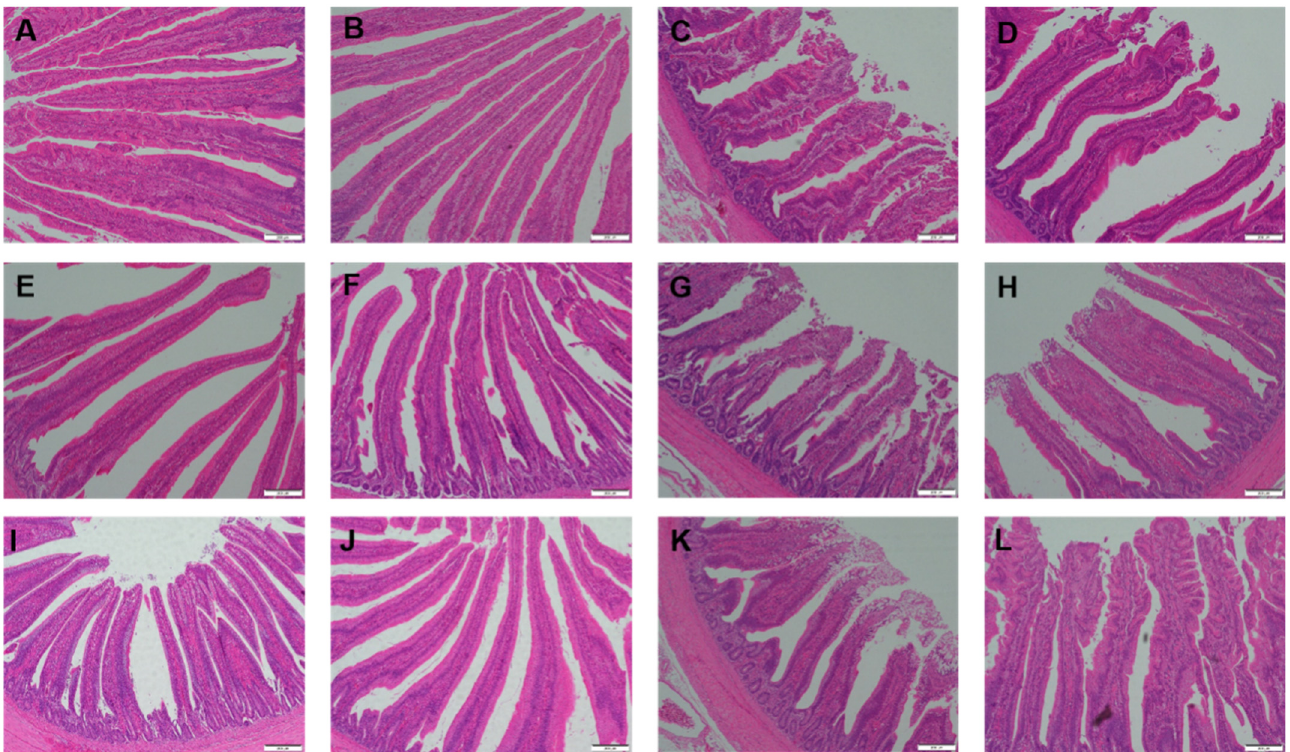
Figure 1. Intestinal mucosal histological appearance (hematoxylin and eosin) of the effect of Cardamine violifolia on the intestinal morphology of broilers challenged and unchallenged intraperitoneally with LPS. Original magnification 100×. Scale bars = 200 μ m. ( A – D ) Duodenum histological appearance of the broilers treated by SeNa-SS, SeCv-SS, SeNa-LPS, and SeCv-LPS, respectively. ( E – H ) Jejunum histological appearance of the broilers treated by SeNa-SS, SeCv-SS, SeNa-LPS, and SeCv-LPS, respectively. ( I – L ) Ileum histological appearance of the broilers SeNa-SS, SeCv-SS, SeNa-LPS, and SeCv-LPS, respectively.